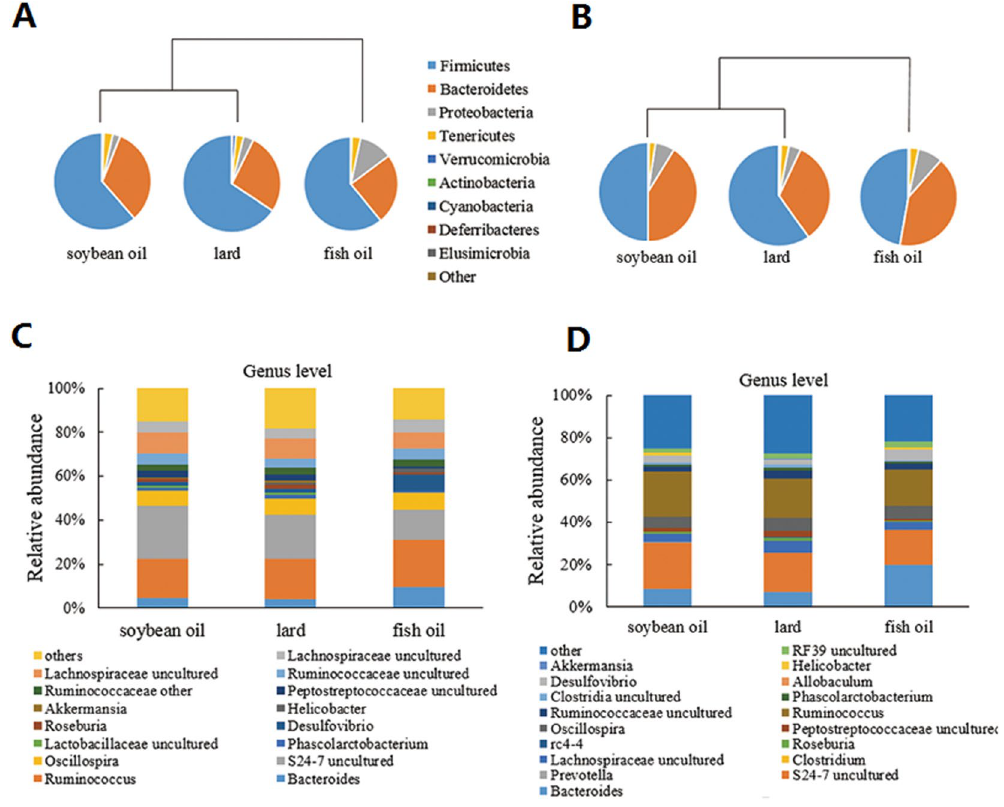
Figure 1. Gut microbiota in response to dietary fats. ( A ) Relative abundance of caecel microbiota on the phylum level. ( B ) Relative abundance of colonic microbiota on the phylum level. ( C ) Relative abundance of caecal microbiota on the genus level. ( D ) Relative abundance of colonic microbiota on the genus